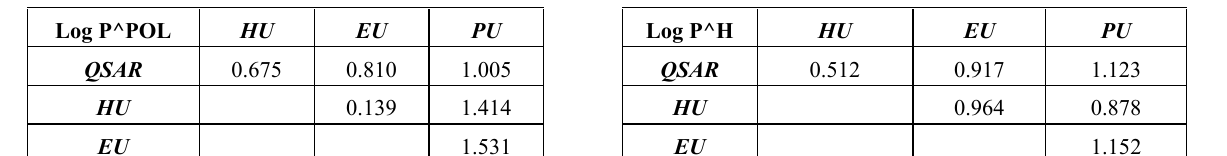
Table 9. Single-structure matrices of the Euclidean distances employing Equation (12); note that for the degenerate models of Table 6 that one is employed that displays higher relative statistical power ( 